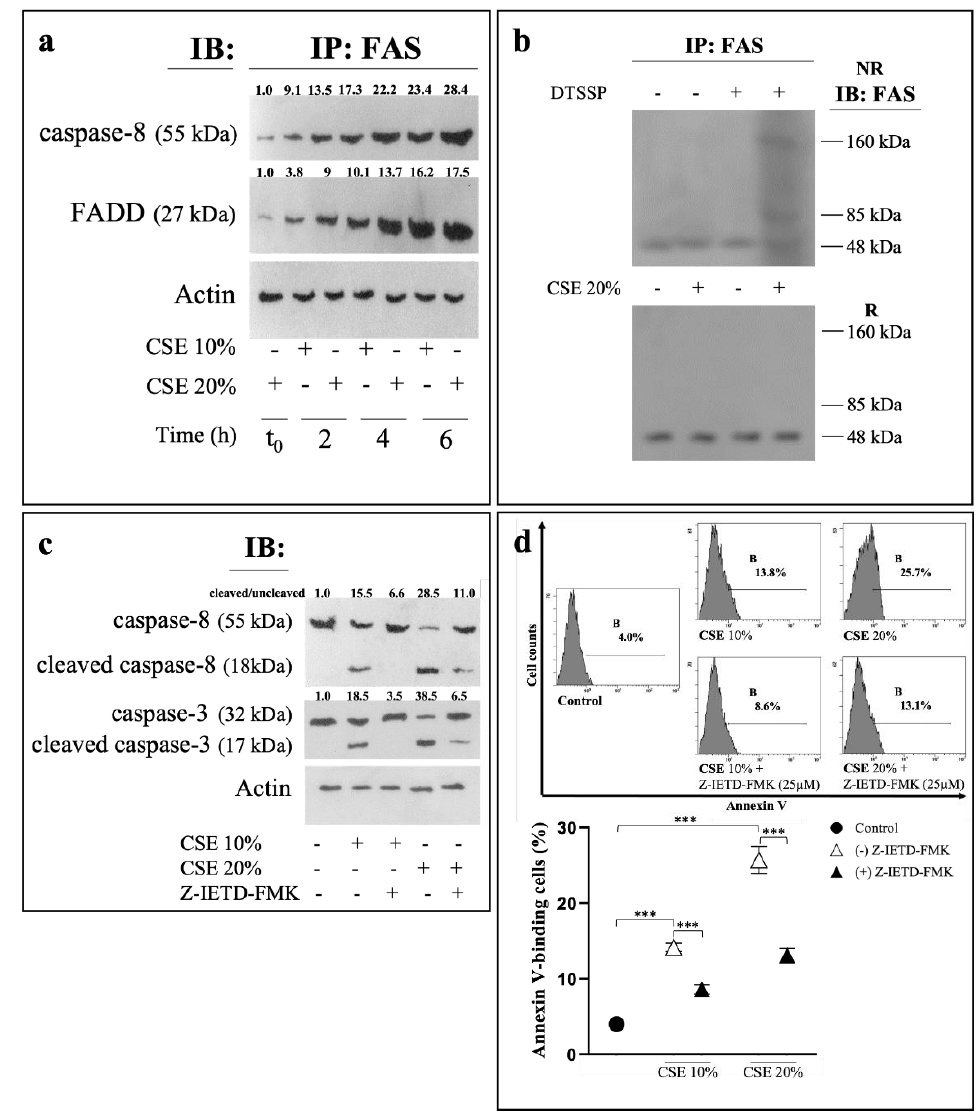
Figure 3. CSE induces eryptosis through extrinsic signaling pathway activation. ( a ) RBCs treated at different time intervals with CSE were lysed and immunoprecipitated with anti-Fas antibody. The immunoprecipitates (IP) were separated by SDS-PAGE and blotted with anti-FADD or anti-caspase-8. Blots were reprobed with anti-Fas antibody to ensure equal loading of the gels. ( b ) Oligomerization of Fas. Thirty min before the end of treatment (6 h) with CSE, RBCs were either left untreated or treated with the thiol-cleavable cross-linker DTSSP (1 mM). The IP with anti-Fas were separated by SDS-PAGE under NR and R conditions and blotted with anti-Fas antibody. Blots are representative of the results obtained in three separate experiments with comparable results. ( c ) Western blot analysis of caspases-8/3. The numbers below each line represent the relative expression level normalised to actin, as determined on the basis of the intensity of the band. Representative image of three experiments with similar results. ( d ) Percentage of PS-exposing cells in RBCs pre-incubated for 1 h in the absence or in the presence of the caspase-8 inhibitor Z-IETD-FMK (25 μM) before the treatment with CSE for 6 or 24 h, respectively. RBCs incubated with vehicle were used as control. Values are means ± SD of six independent experiments carried out in triplicate. *** p < 0.001 (ANOVA associated with Tukey’s test).